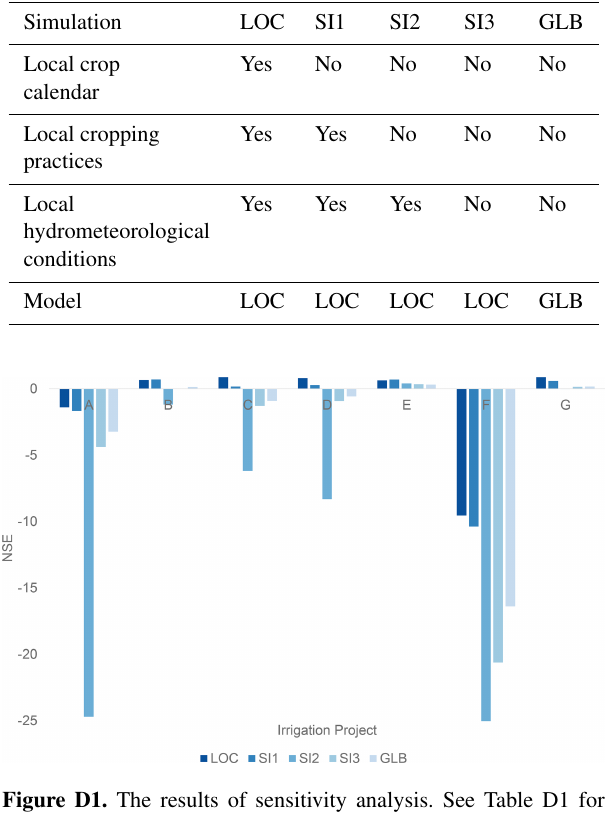
Table D1. Sensitivity simulation on irrigation requirement.